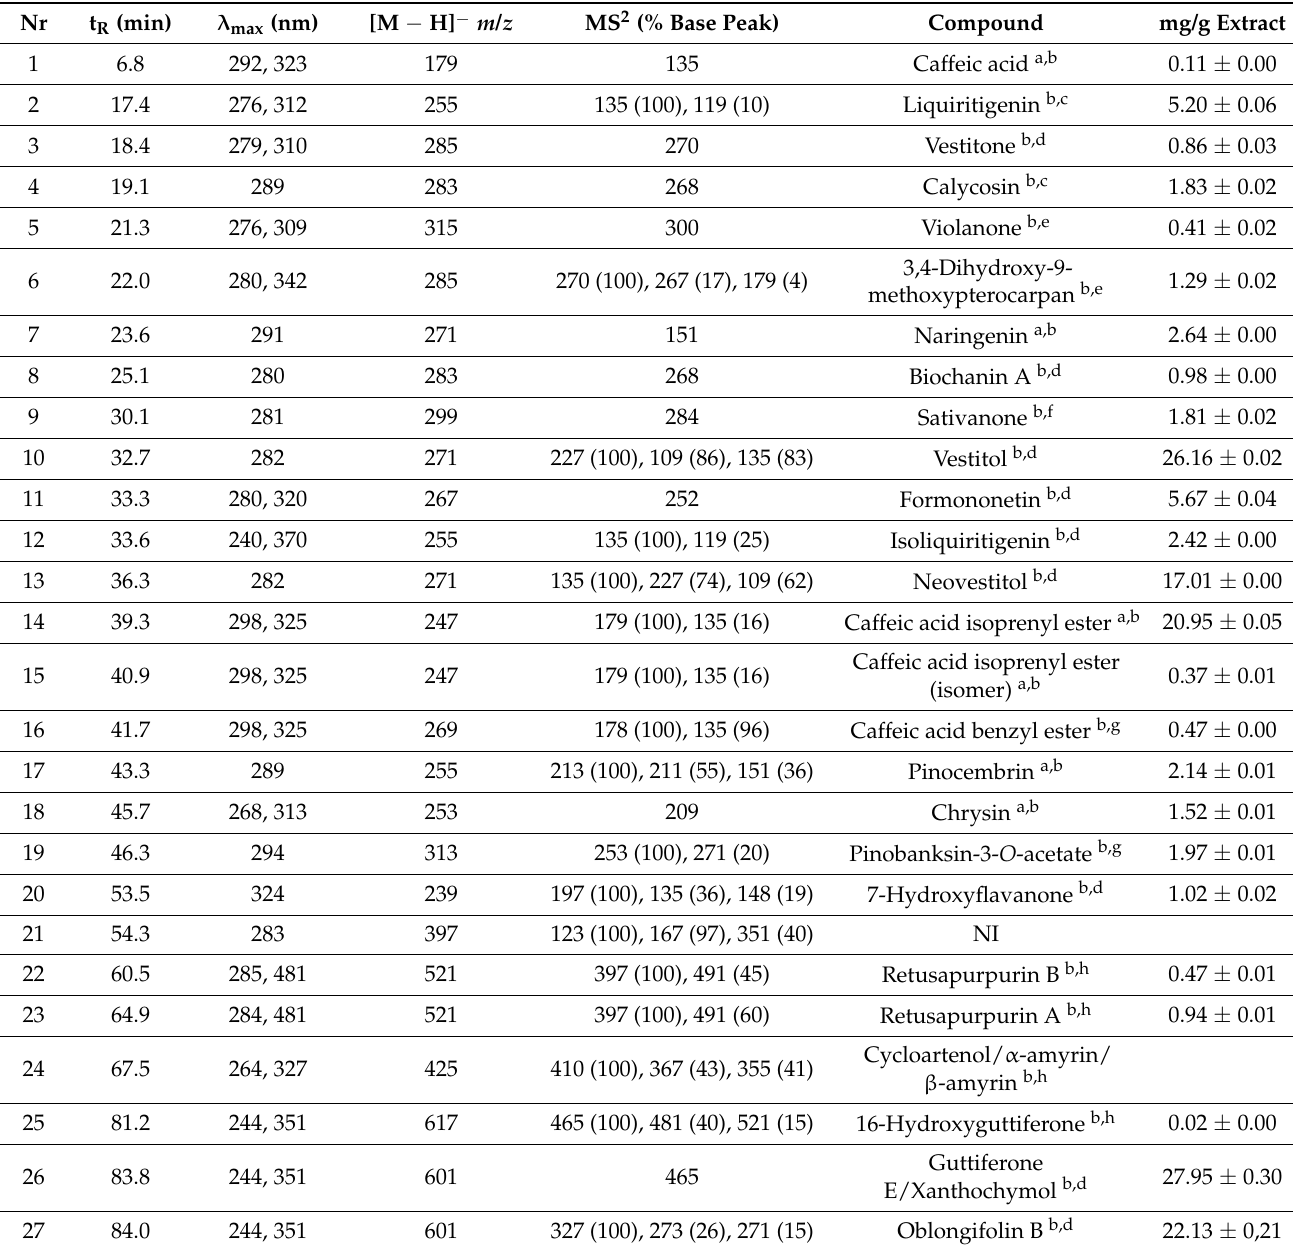
Table 2. Characterization of the phenolic compounds in red propolis extract, obtained by LC/DAD/ESI-MS n